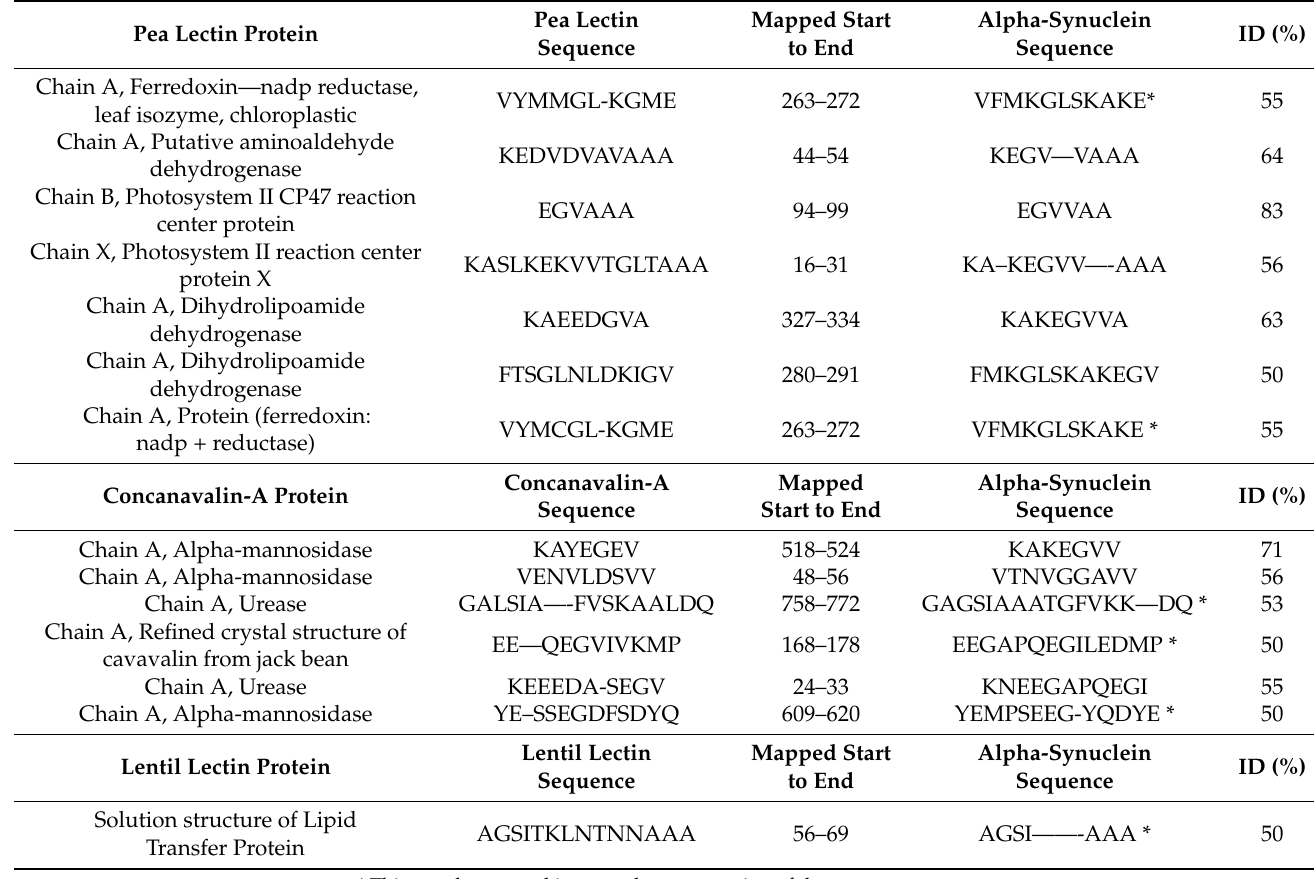
Table 5. Potential cross-reactive epitopes between alpha-synuclein proteins and pea lectin, concanavalin-A (bean agglutinin) and lentil lectin proteins.